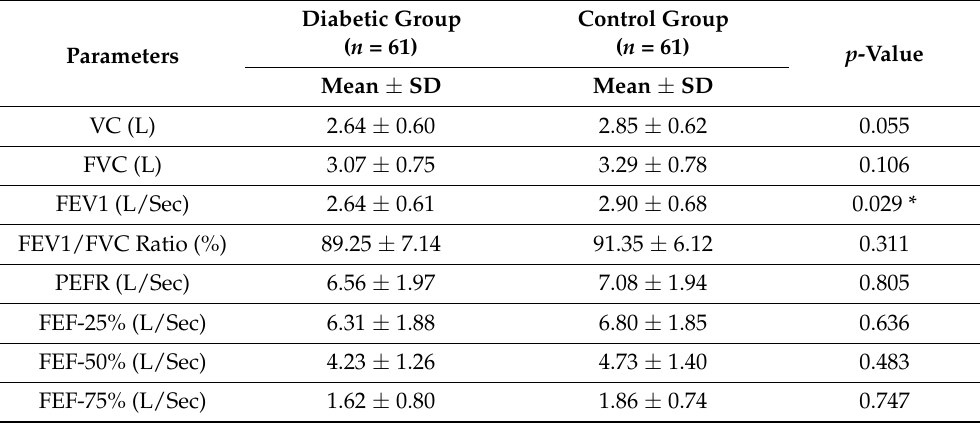
Table 4. Lung function parameters for type 2 diabetic patients with duration of disease > 10 years compared with their matched controls.